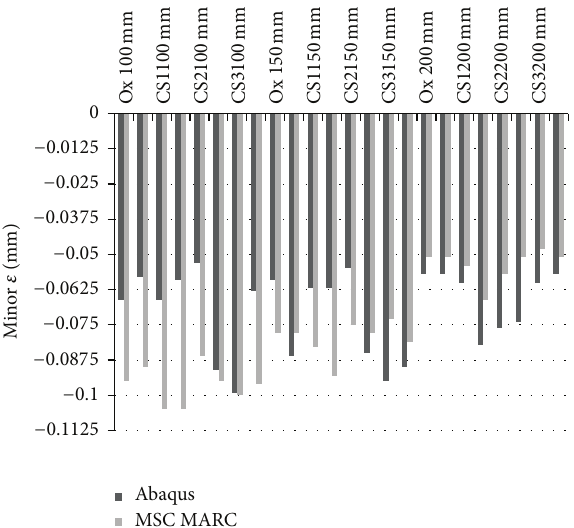
Figure 30: Minimum deformation for the Nakajima tests: comparison between MSC-MARC and